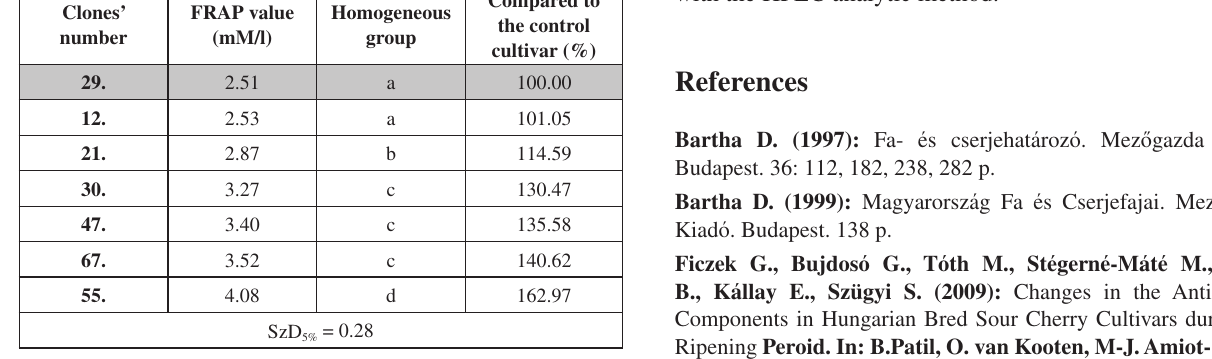
Table 11. Lycium clones’ average FRAP values (mM/l), 2011 Clones’ number